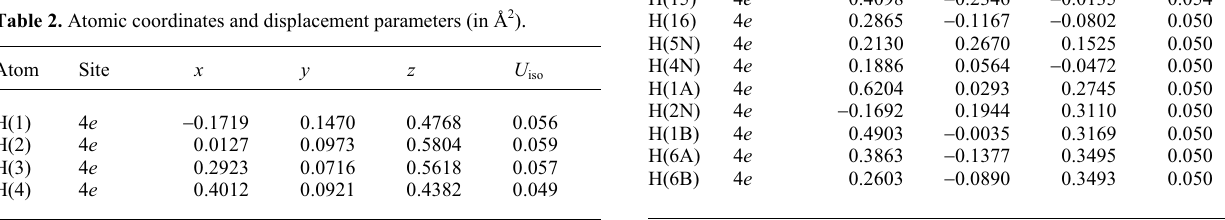
Table 3. Atomic coordinates and displacement parameters (in Å 2 ) .